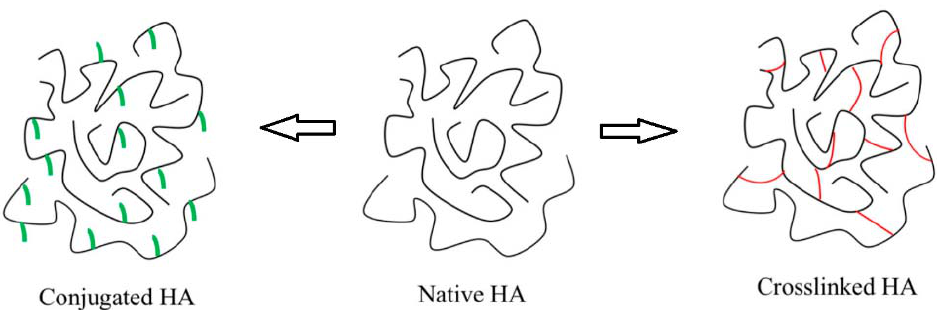
Figure 2. HA forms used for pharmaceutical, medical and cosmetic applications: native, conjugated and crosslinked. Adapted with permission from [13].